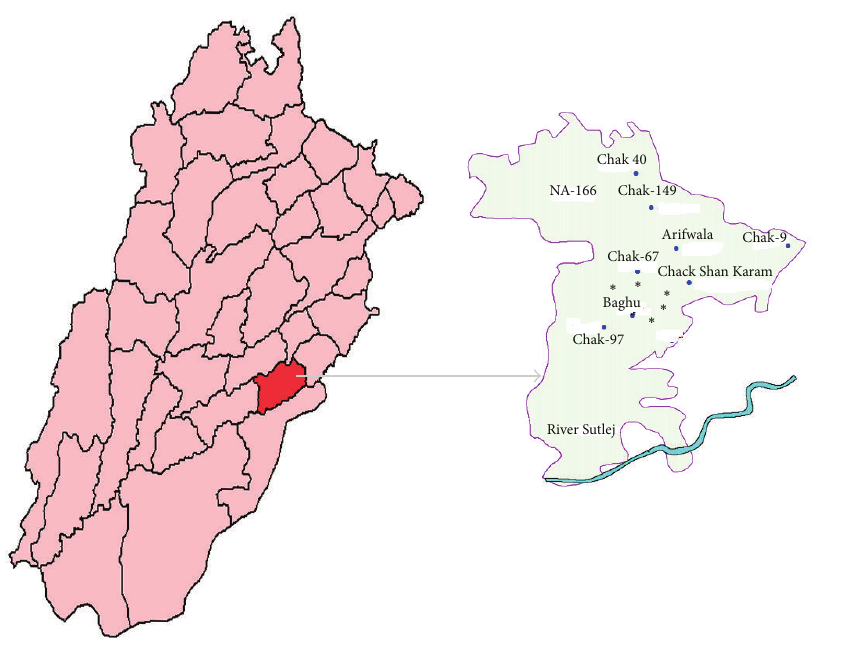
Figure 1: Location map of sampling sites ∗